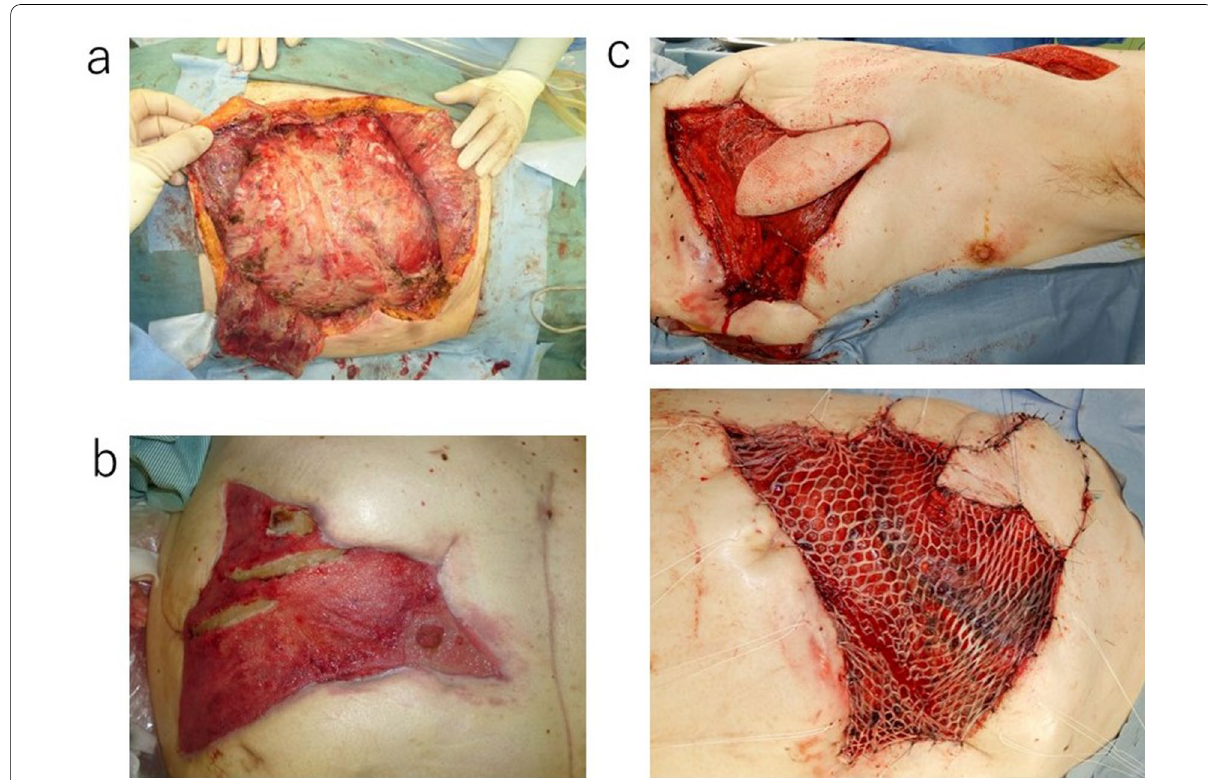
Fig. 4 a The infected area was incised and opened on the 16th day after TAE. b NPWT was started on the 16th day after TAE. c The patient underwent debridement of the infected area on the 78th day after TAE, and simultaneous flap plasty with musculus latissimus dorsi (above) and skin grafting from the right buttock were performed (below) to close the wound from the right anterior chest to the upper abdomen in collaboration with the department of plastic